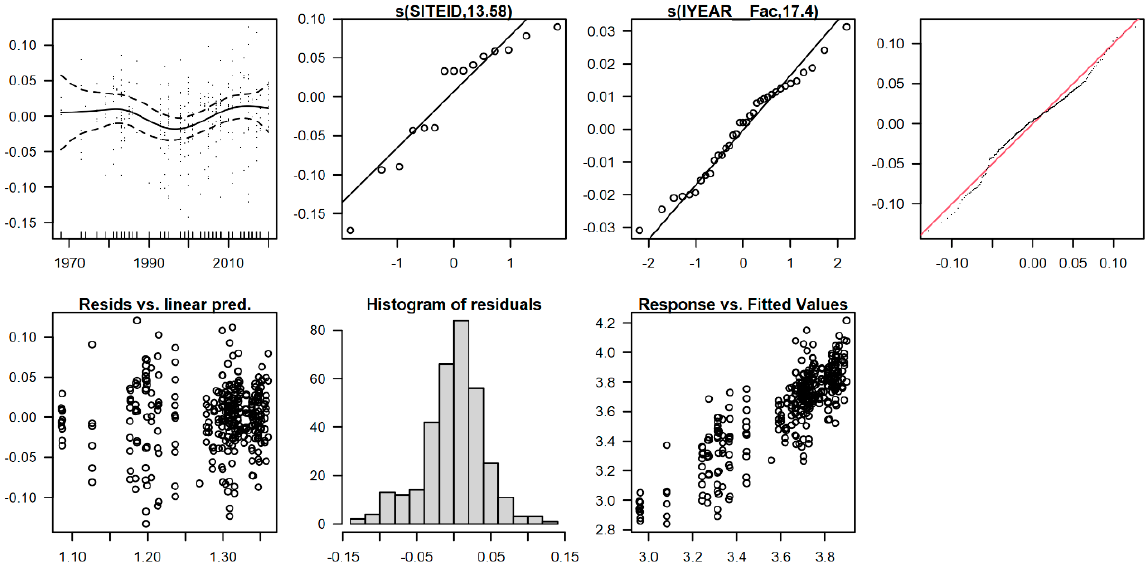
Figure A4. Example of graphical residual analysis (normality; homogeneity) of the selected generalized additive mixed model (GAMM) for pH(CaCl 2 ) values at unlimed plots in a 0–30 cm soil depth.